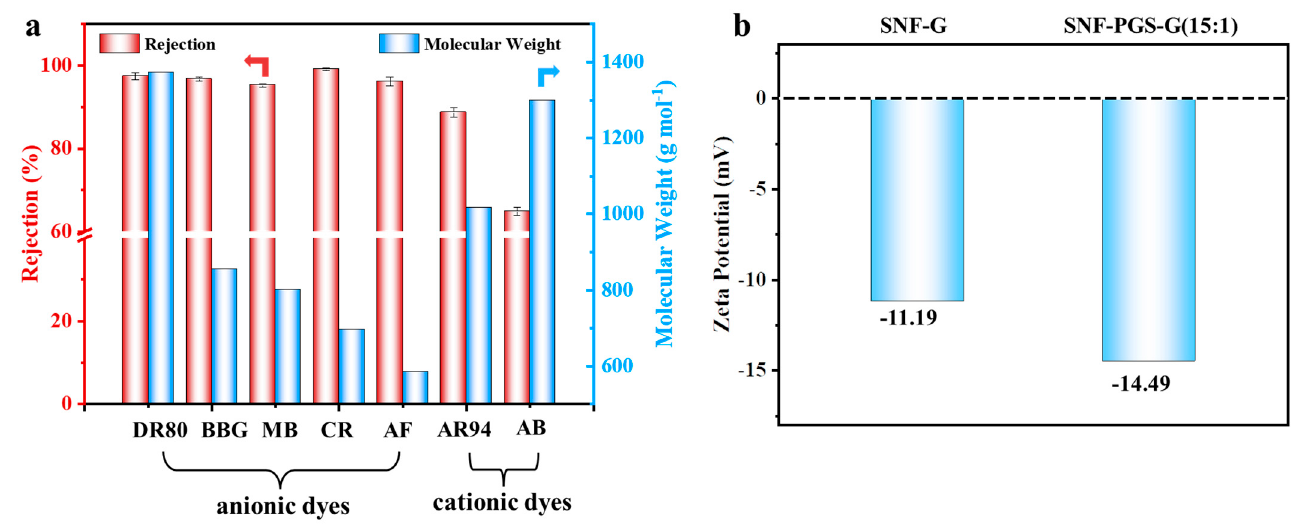
Figure 8. ( a ) The filtration performance of SNF-PGS-G composite membrane for different dyes with different molecular weights; ( b ) zeta potential values of the SNF-G membrane and SNF-PGS-G (15:1) composite membrane.